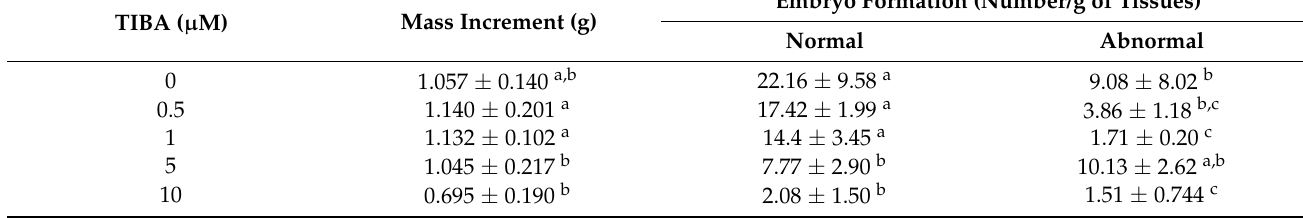
Table 1. Results of the auxin polar transport inhibitors assay. Values are presented as mean ± SD ( n = 4); values in the same column with different letters are statistically different by Tukey test ( p < 0.05) in the case of the mass increment, while for abnormal embryo formation the letters refer to Dunn’s multiple comparison test.